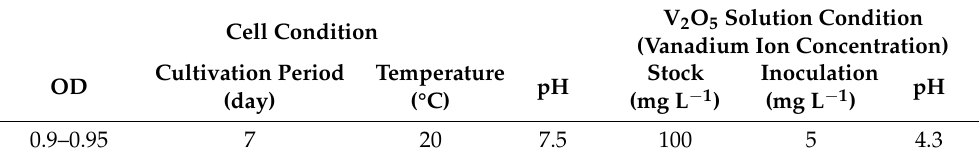
Table 1. List of various physical and chemical parameters used for cell culture. Basic information applies equally to all species in this